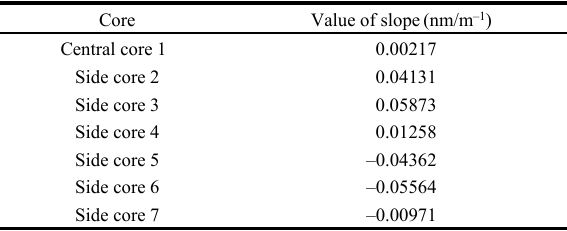
Table 1 Linear fitting statistics.